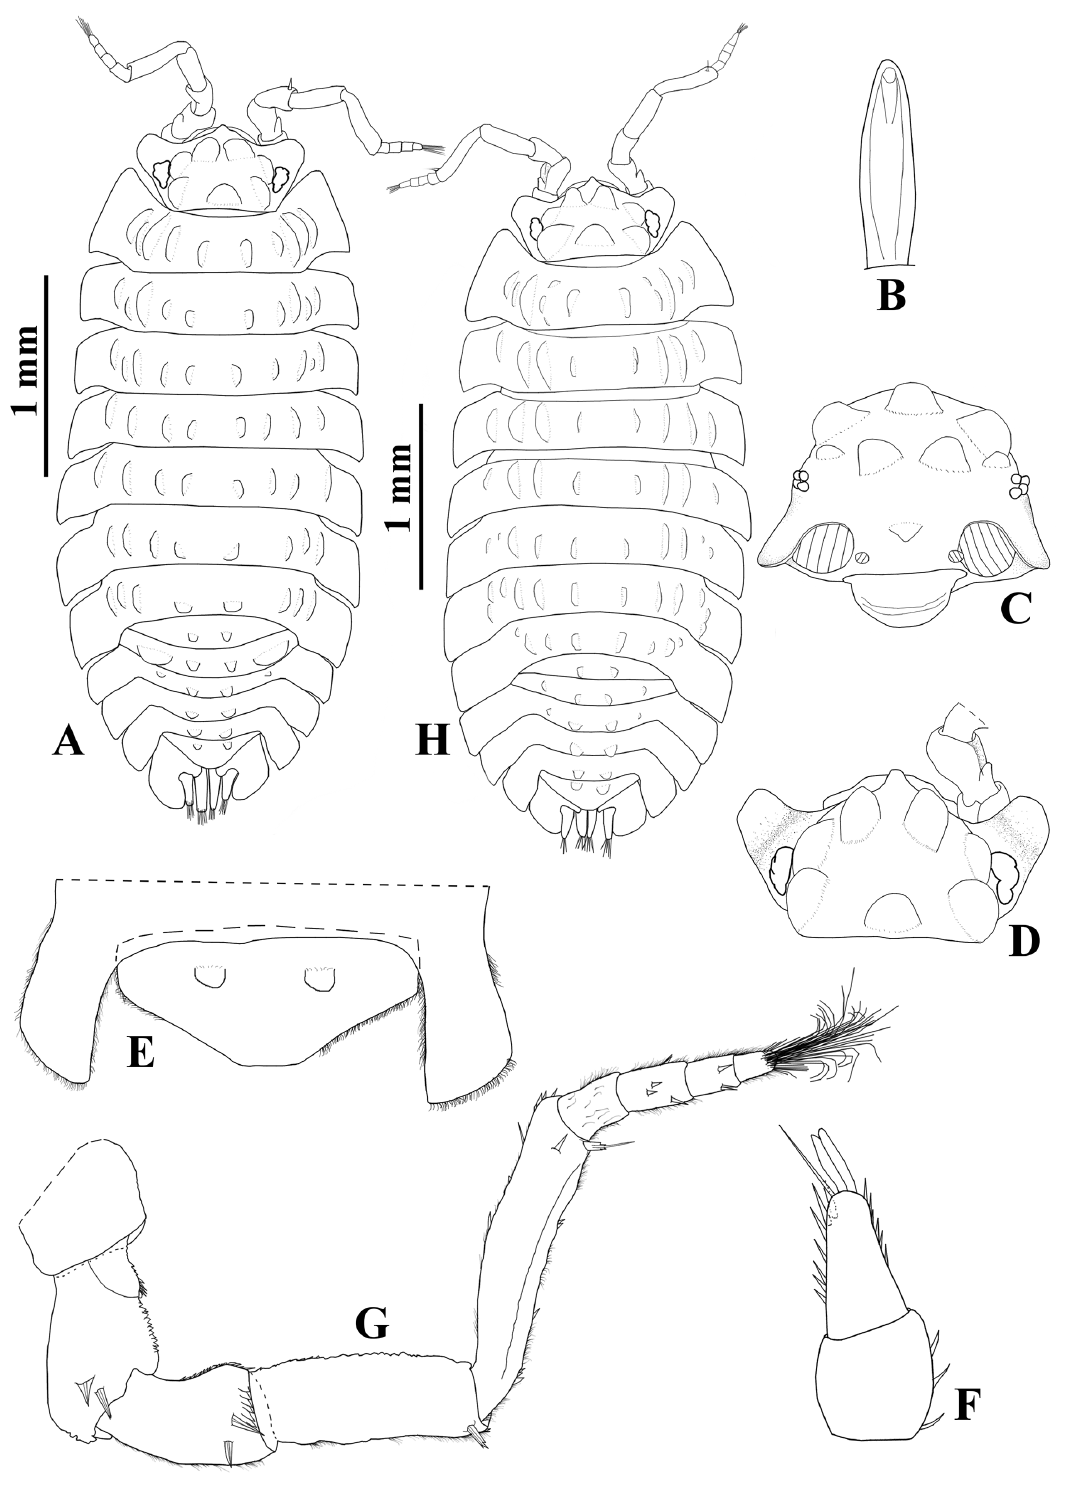
Fig. 10. Armadilloniscus luisi Carpio-Díaz, Taiti & Campos-Filho sp. nov. A–G . Paratype, ♂ (CUDC- CRU 194). A . Habitus, dorsal view. B . Dorsal scale-seta. C . Cephalon, frontal view. D . Cephalon, dorsal view. E . Pleonite 5 and telson. F . Antennula. G . Antenna. H . Paratype, ♀ (CDUC-CRU 194), habitus, dorsal